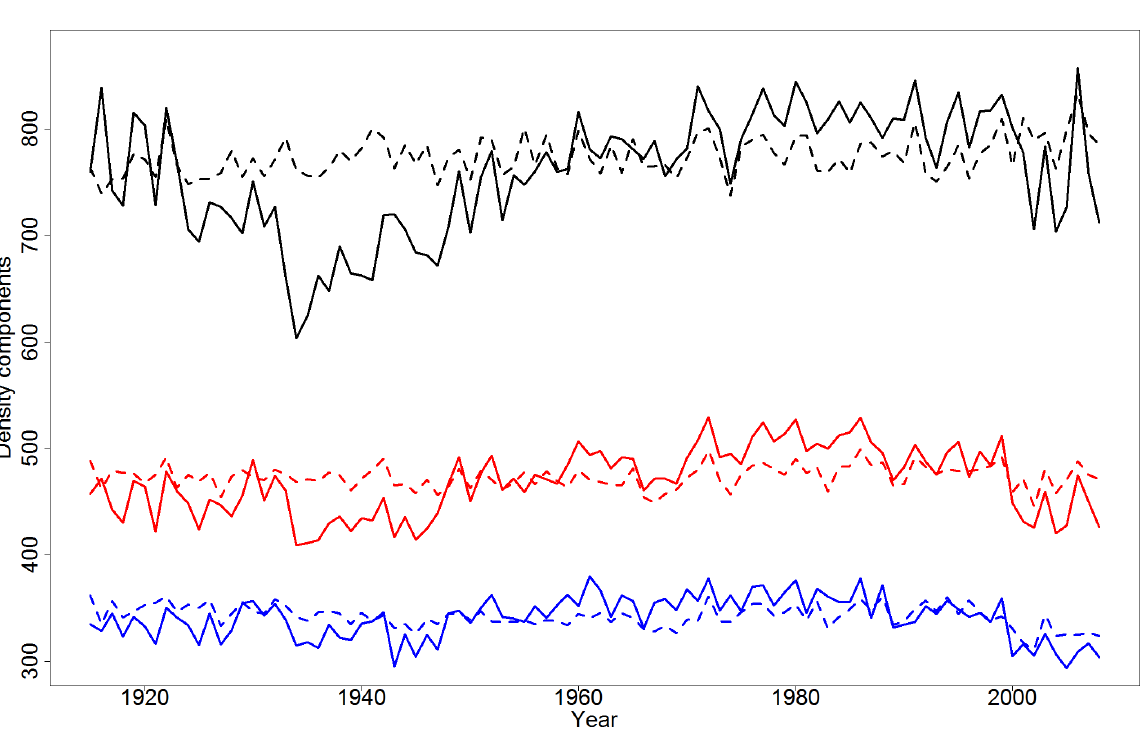
Figure 2. Ring density components (mean observed and predicted values) against calendar year for dominant trees from 1915 to 2008. Observations were displayed by solid lines and predictions were depicted by dashed lines. Different density components are represented by the different colors, minimum ring density (blue lines); maximum ring density (black lines) and average ring density (red